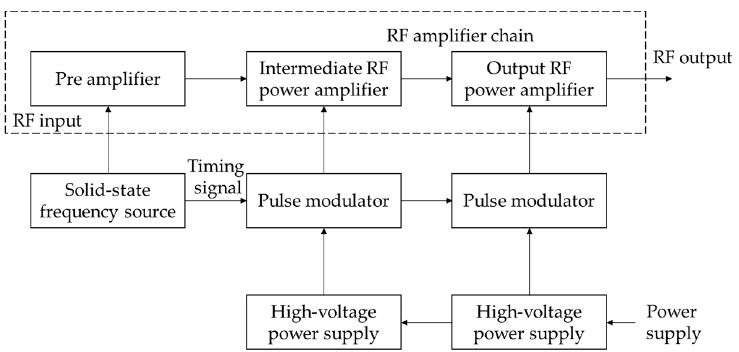
Figure 1. Composition of M.O.P.A. transmitter.